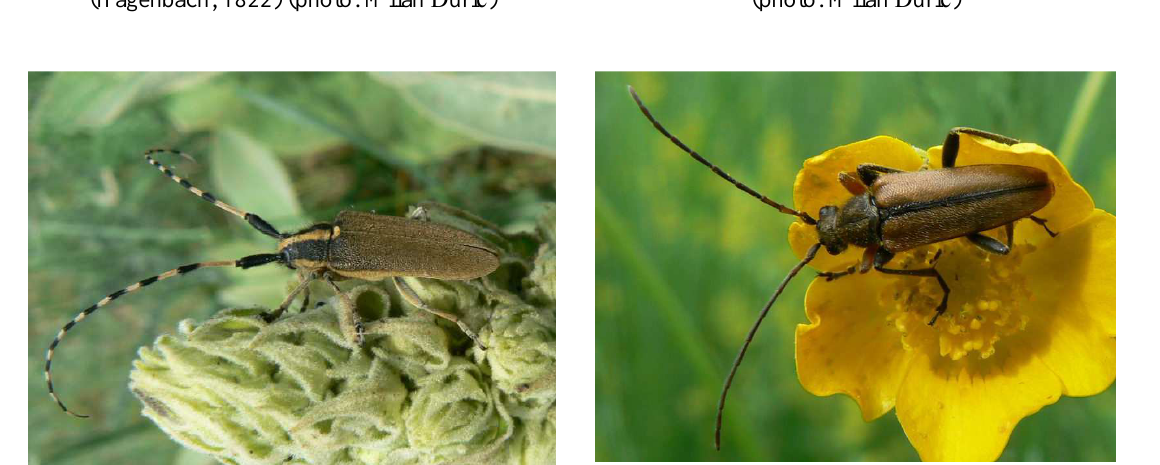
Figure 7. Agapanthia kirbyi (Gyllenhal, 1817) (photo: Milan Đ uri ć )